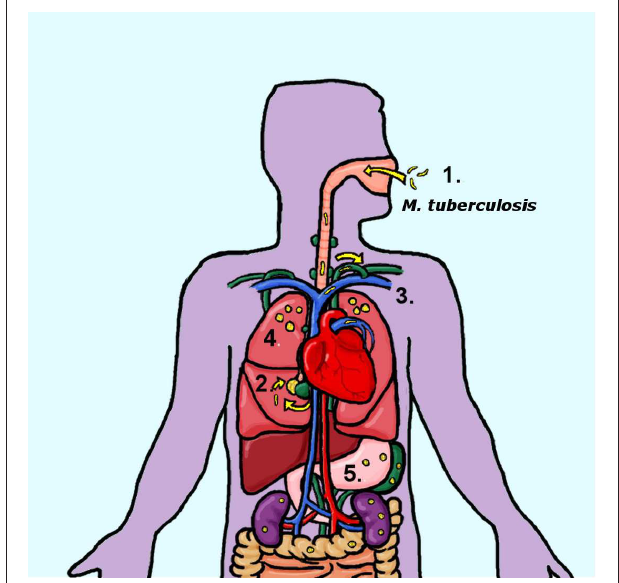
FIGURE 1 | Progression of human M. tuberculosis infections (1) Human tuberculosis infections are transmitted through the inhalation of contaminated aerosols. (2) Primary infections are established in the lungs, at a single site that develops into a primary granuloma. These initial sites of infection include involvement of the surrounding lymph nodes, forming a Ghon’s complex. (3) Bacteria disseminate out of the lungs and into the lymphatic system, most likely entering the circulatory system through the entry of the thoracic duct into the subclavian vein. (4) Hematogenous reseeding of the lungs results in secondary granulomas located in the apical regions of the lungs and/or the extrapulmonary organs (5).